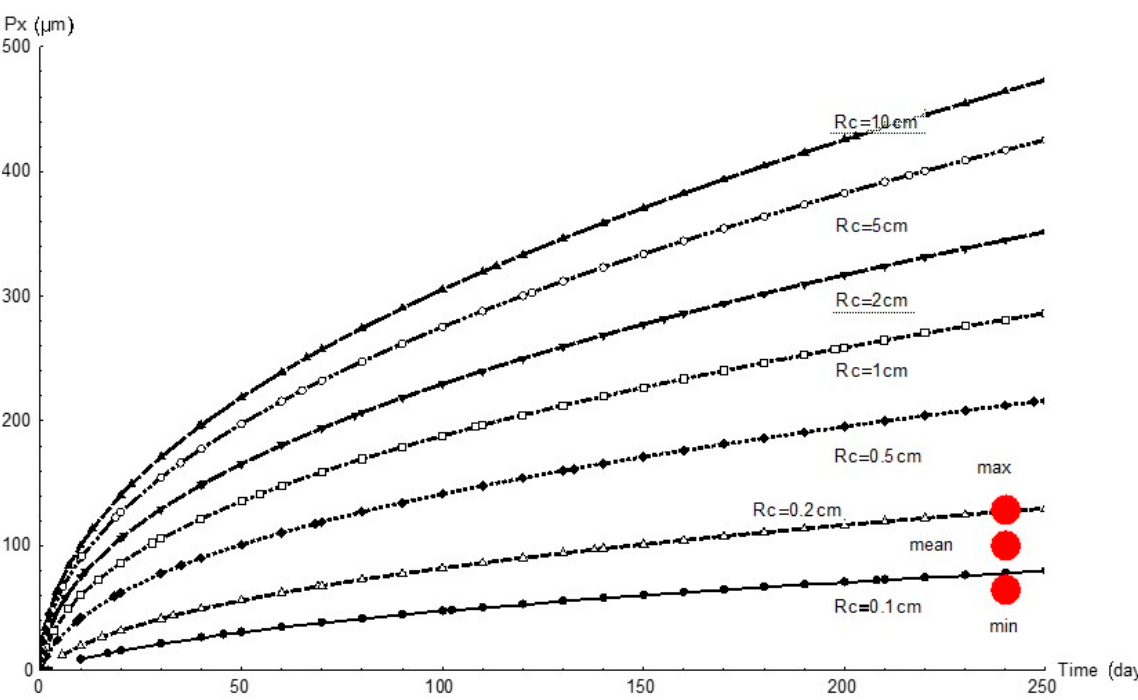
Figure 7. Variation in pit depth, Px , over time for different cathode areas and radii, Rc , and comparison with experimental values (red circles).